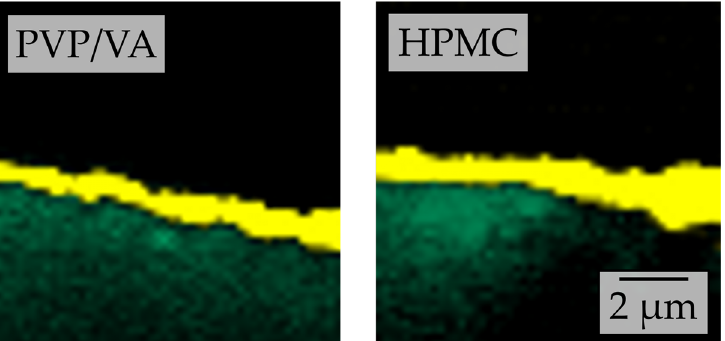
Figure 11. Comparative depth scans conducted by confocal Raman microscopy of granules produced with a naproxen (yellow false color according to reference spectra) nanosuspension stabilized with PVP/VA or HPMC without additional drying excipient and with lactose (green false color according to reference spectra) carrier particles.